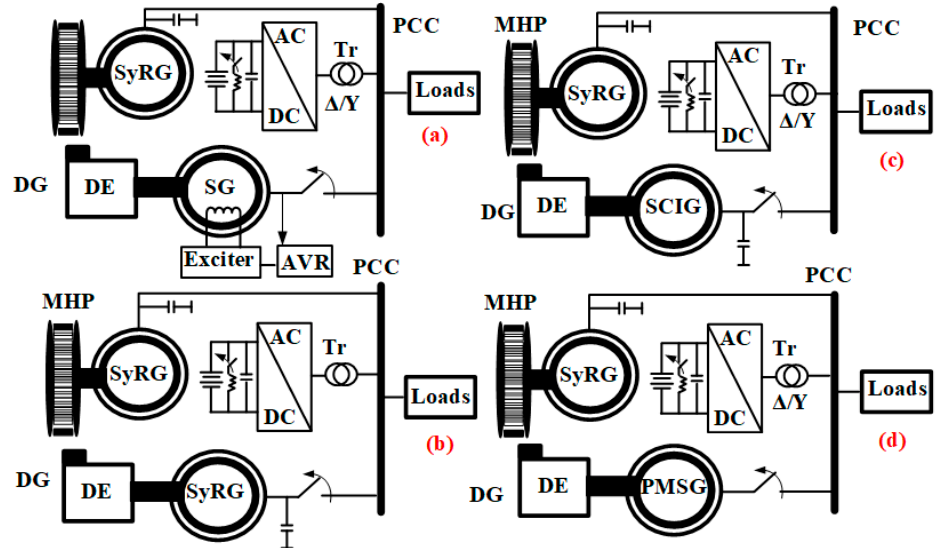
Figure 2. Off-grid configurations having MHP driven SyRG and DE driven: ( a ) SG, ( b ) SyRG, ( c ) SCIG, and ( d ) PMSG.